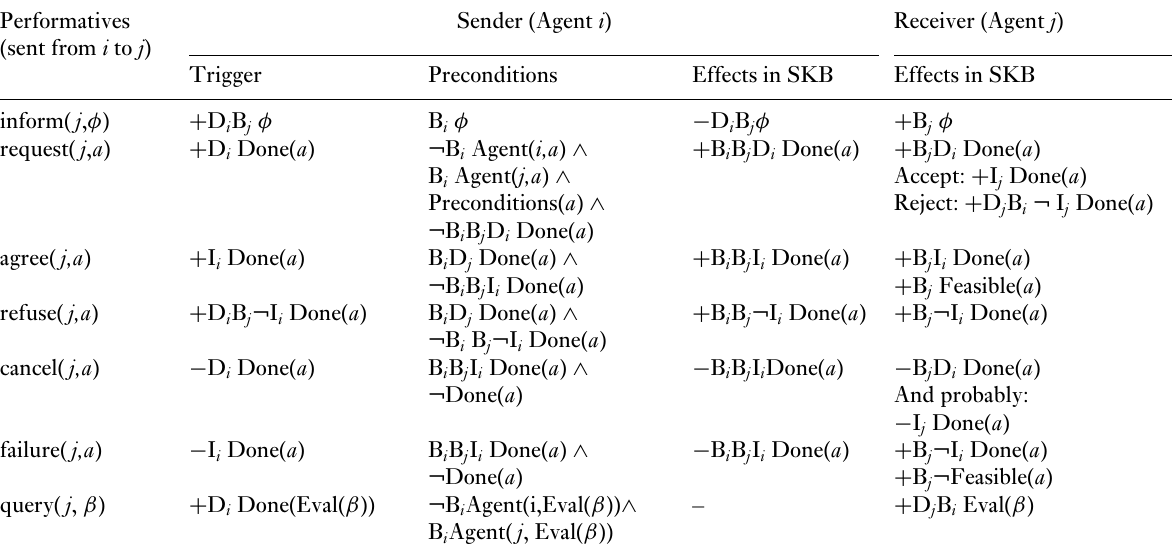
Table 1 The communication acts that we use in our system to define the semantics of inter-agent communications